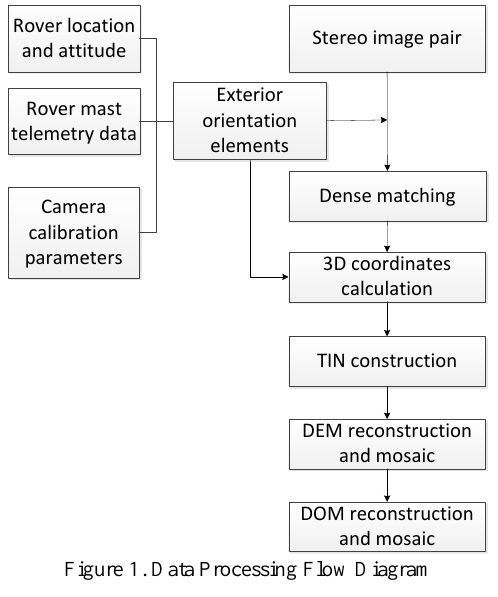
Figure 1. Data Processing Flow Diagram